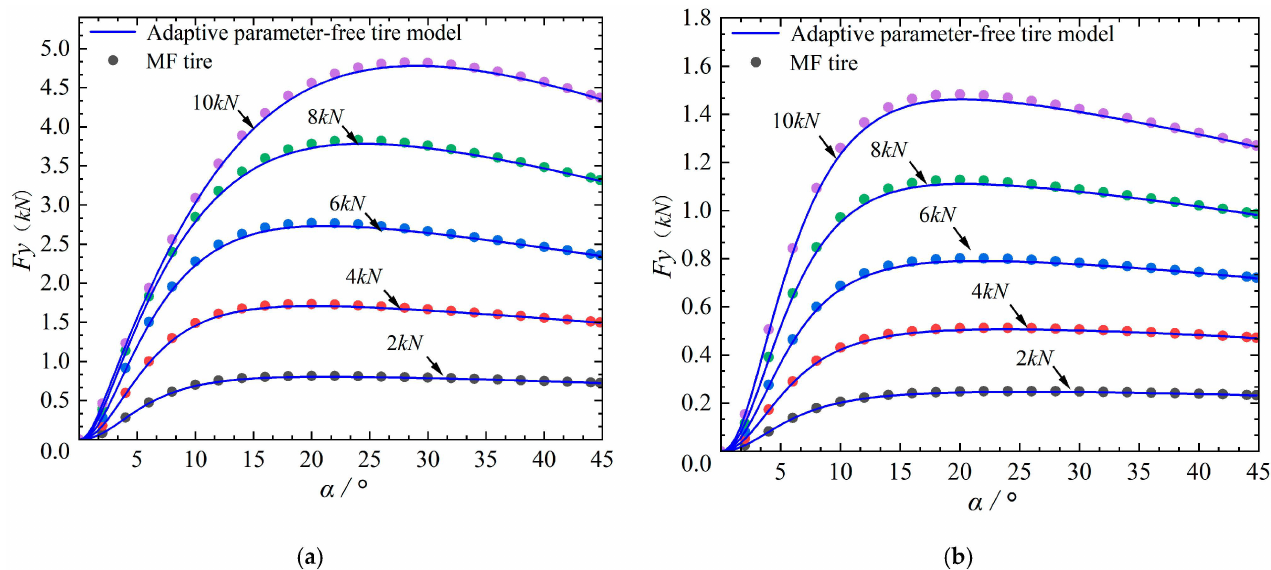
Figure 7. Lateral force contrast curve. ( a ) µ = 0.9. ( b ) µ =